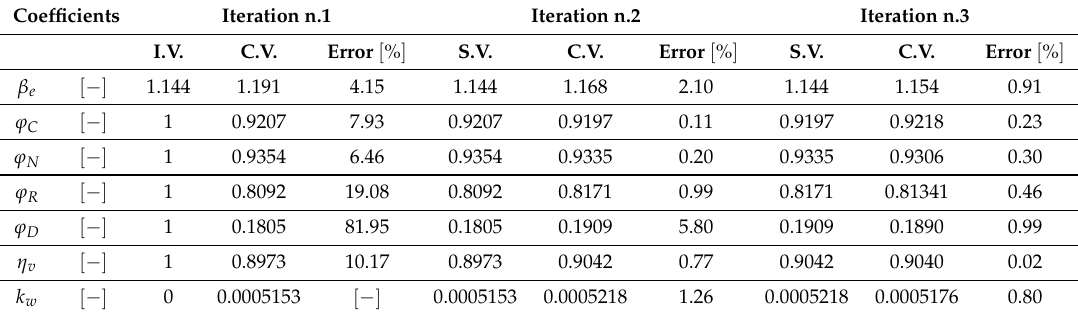
Table 3. Input Values (I.V.) of the first iteration and Supposed Values (S.V.) of the next iterations together with the Computed Values (C.V.) for loss coefficients off all the three